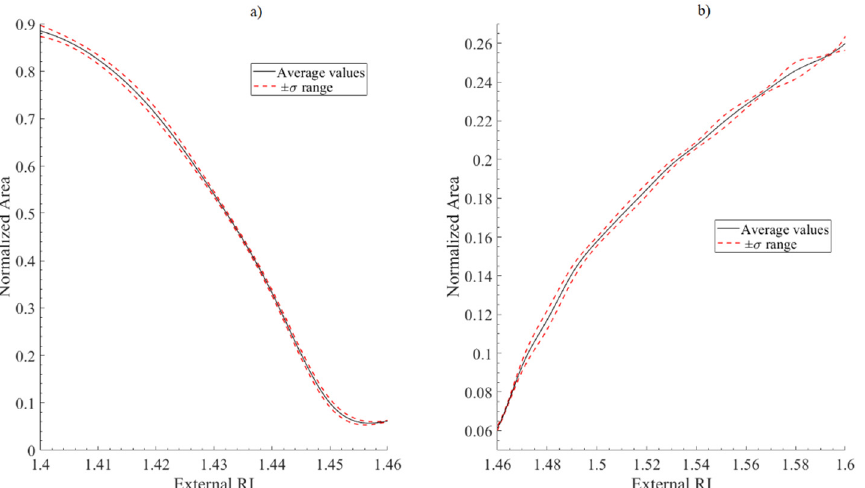
Figure 6. Ten correlation points measured with TFBG sensor for each used RI liquid.